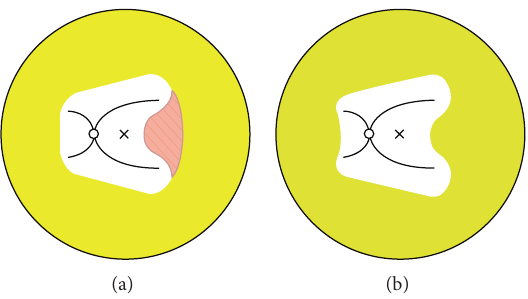
Figure 2: Diagrammatic presentation of the two groups. (a) In Group 1, with avascular area within 2DD from foveal center, laser therapies sparing posterior pole with IVB were applied. (b) In Group 2, without avascular area within 2 DD from foveal center, complete confluent laser without spared zone and IVB were performed. DD: disc diameter; IVB: intravitreal bevacizumab